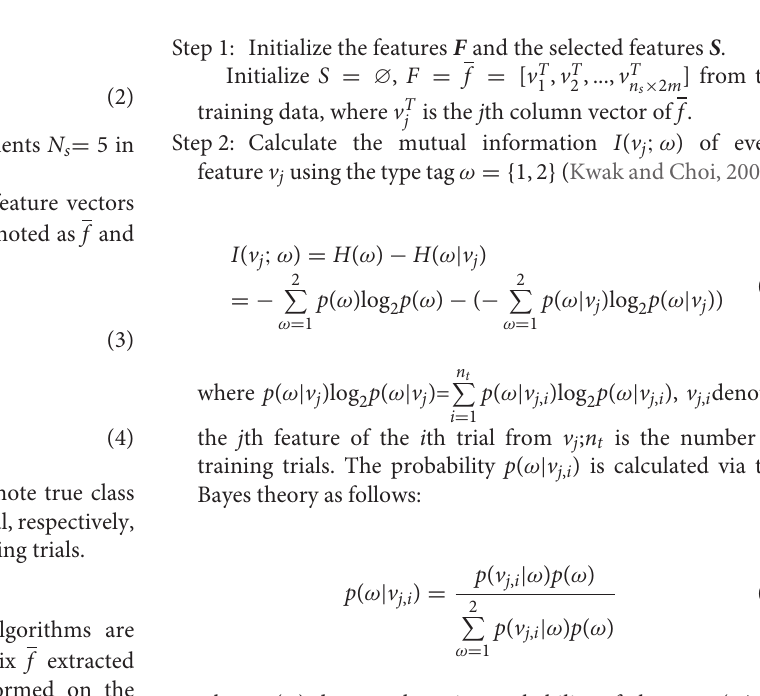
FIGURE 1 | Illustration of temporal combination pattern optimization